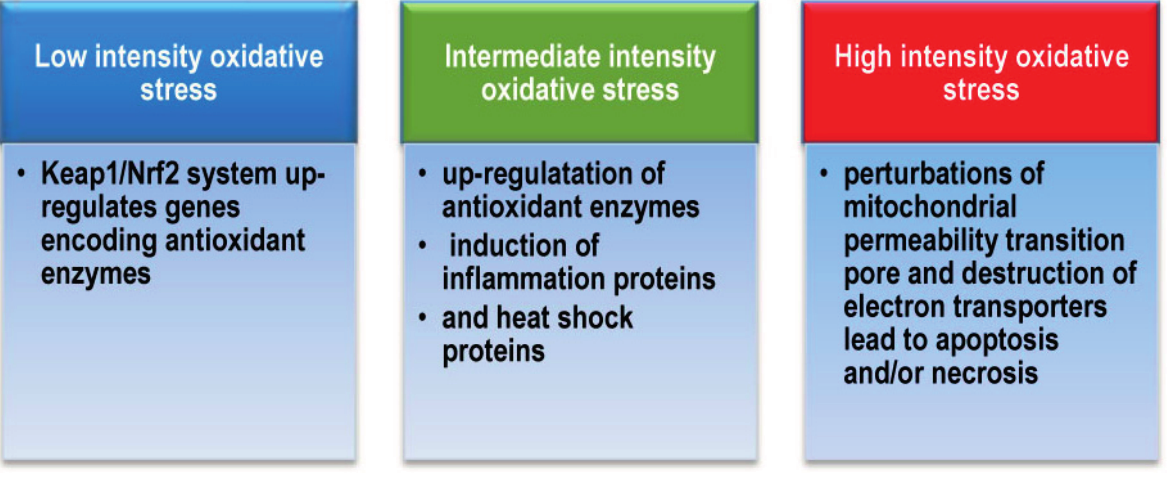
Figure 5. Human and animal organism system of adaptive response to ROS